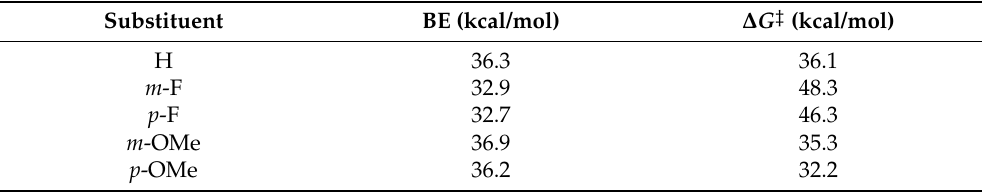
Table 1. Substituents introduced into the Ph group in TetraPB − , binding energy (BE) of the P-B bond, and ∆ G ‡ values in triphenylborane-forming reaction. Substituent BE